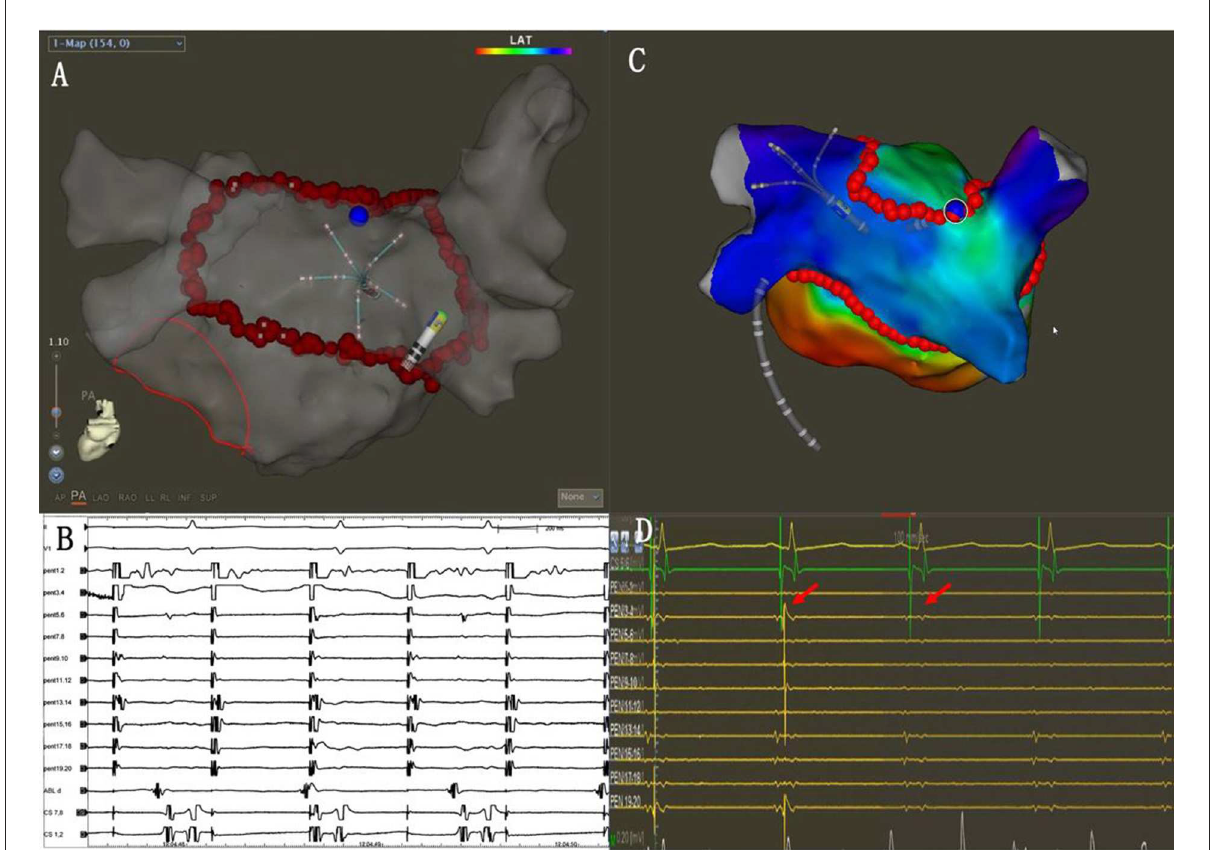
FIGURE3 (A) The PENTARAY ® catheter was placed at the LAPW. (B) Efferent blocks could be recorded when pacing at the LAPW. (C) Activation mapping when pacing at the distal CS (CSd). The gap was located along the ablation line (blue dots). (D) Additional ablation was performed at the gap, and the potential was eliminated (red